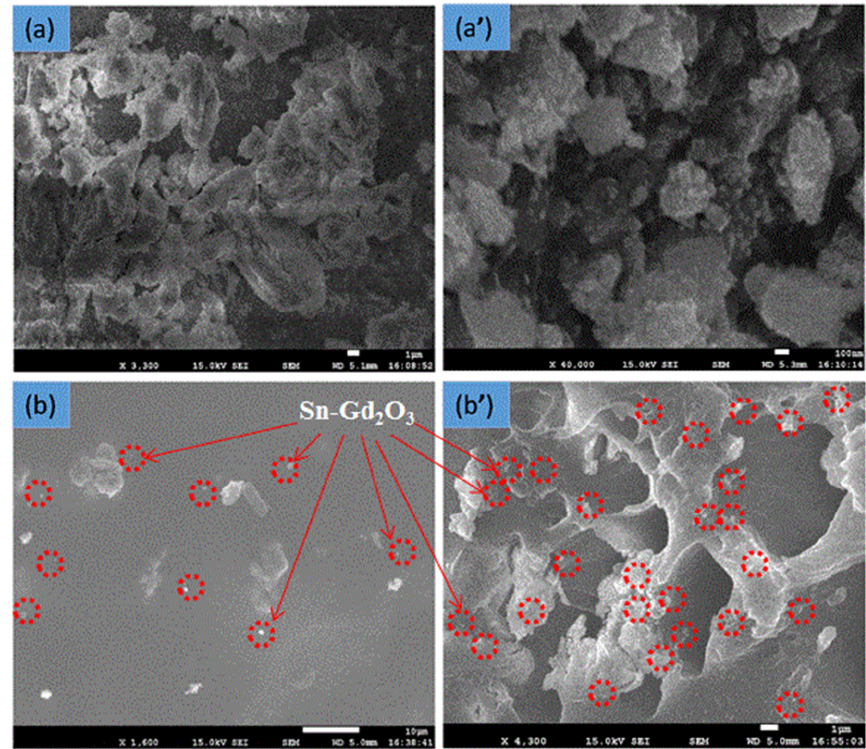
Figure 2. FESEM images of pure Sn-Gd 2 O 3 ( a ) and Sn-Gd 2 O 3 @GH ( b ) at low and their high magni- fication images ( a’ ), ( b’ ).